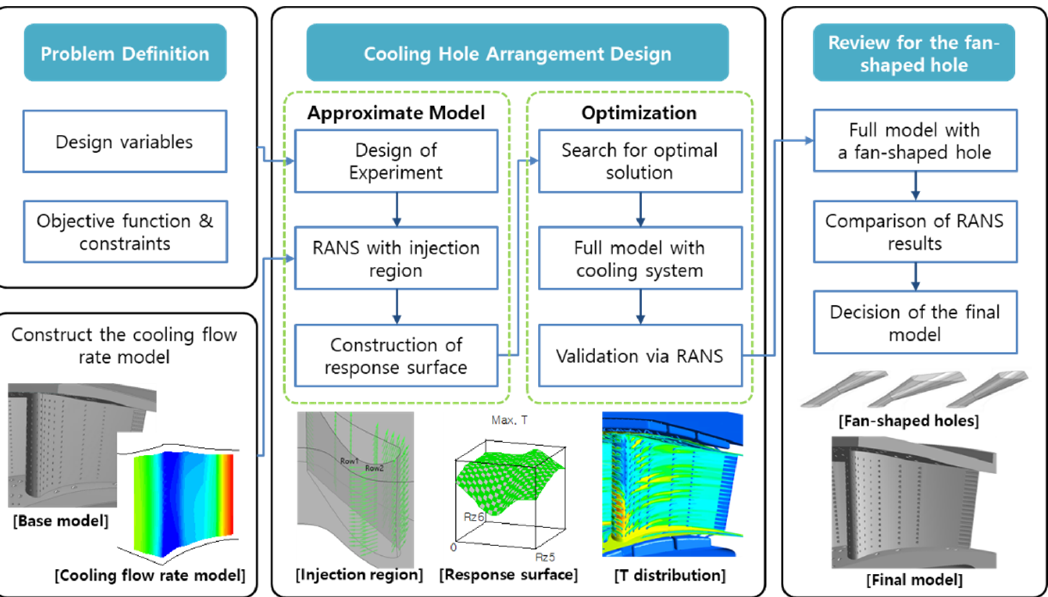
Figure 1. Cooling design flow considering a cooling hole arrangement and a fan-shaped hole (adapted with permission from [16]; copyright 2021 Korean Society for Fluid Machinery).